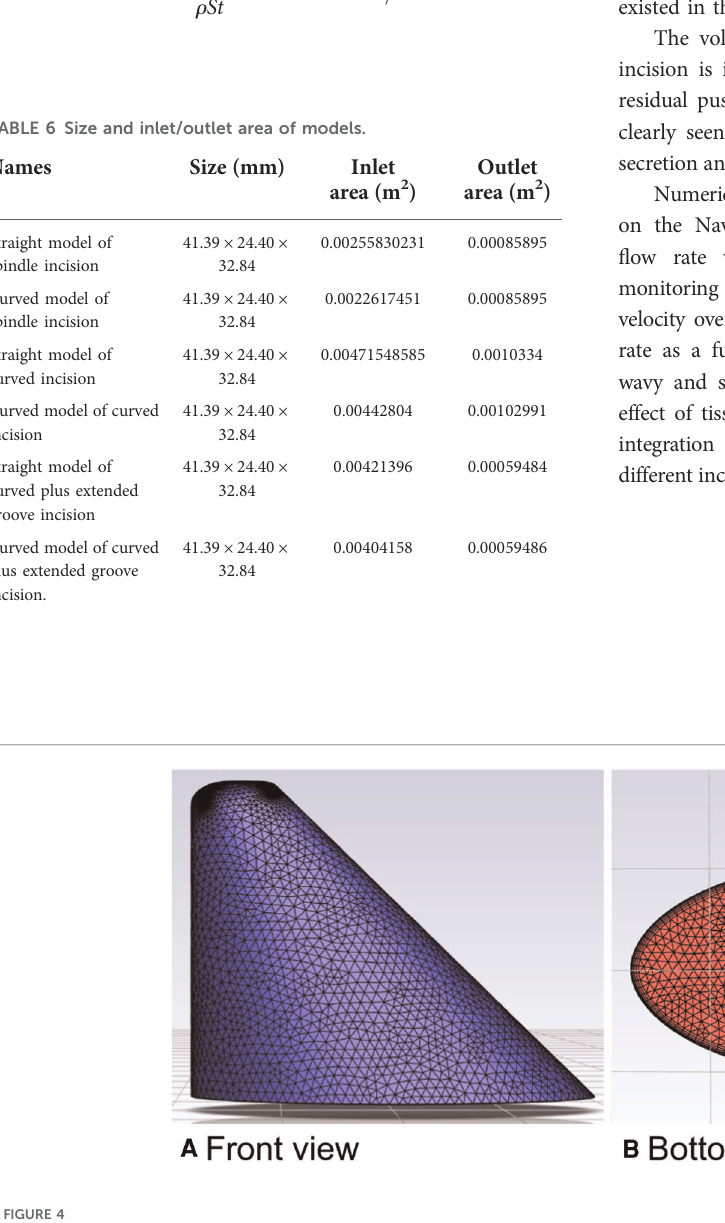
FIGURE 4 Straight model of the spindle